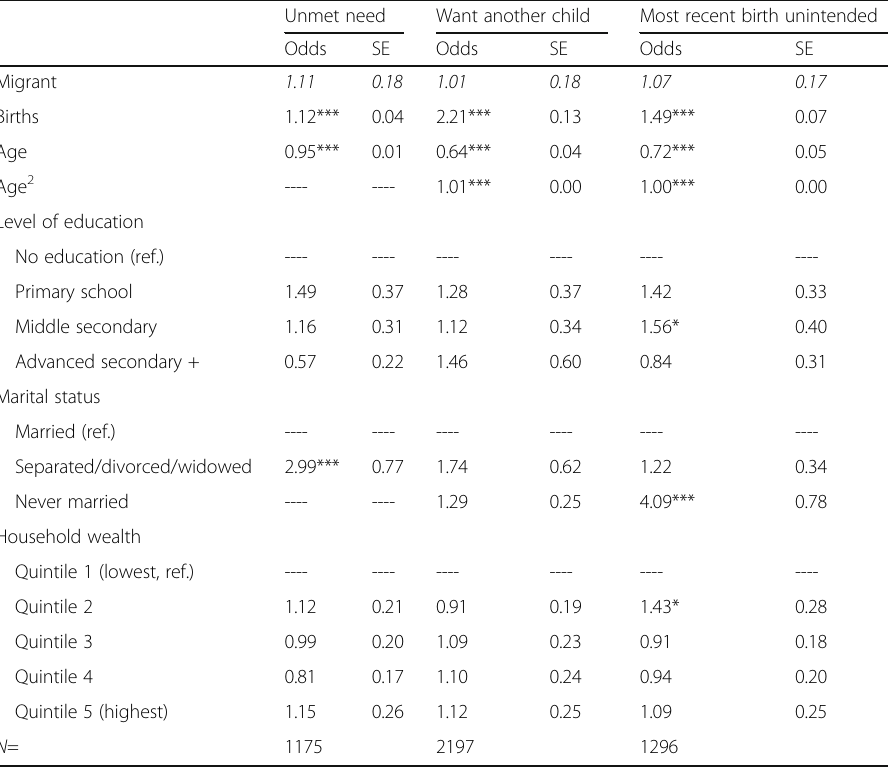
Table 5 Logistic regression results for differences in fertility preferences between migrants and non-migrants, PMA2020 Project, Kinshasa 2013 Unmet need Want another